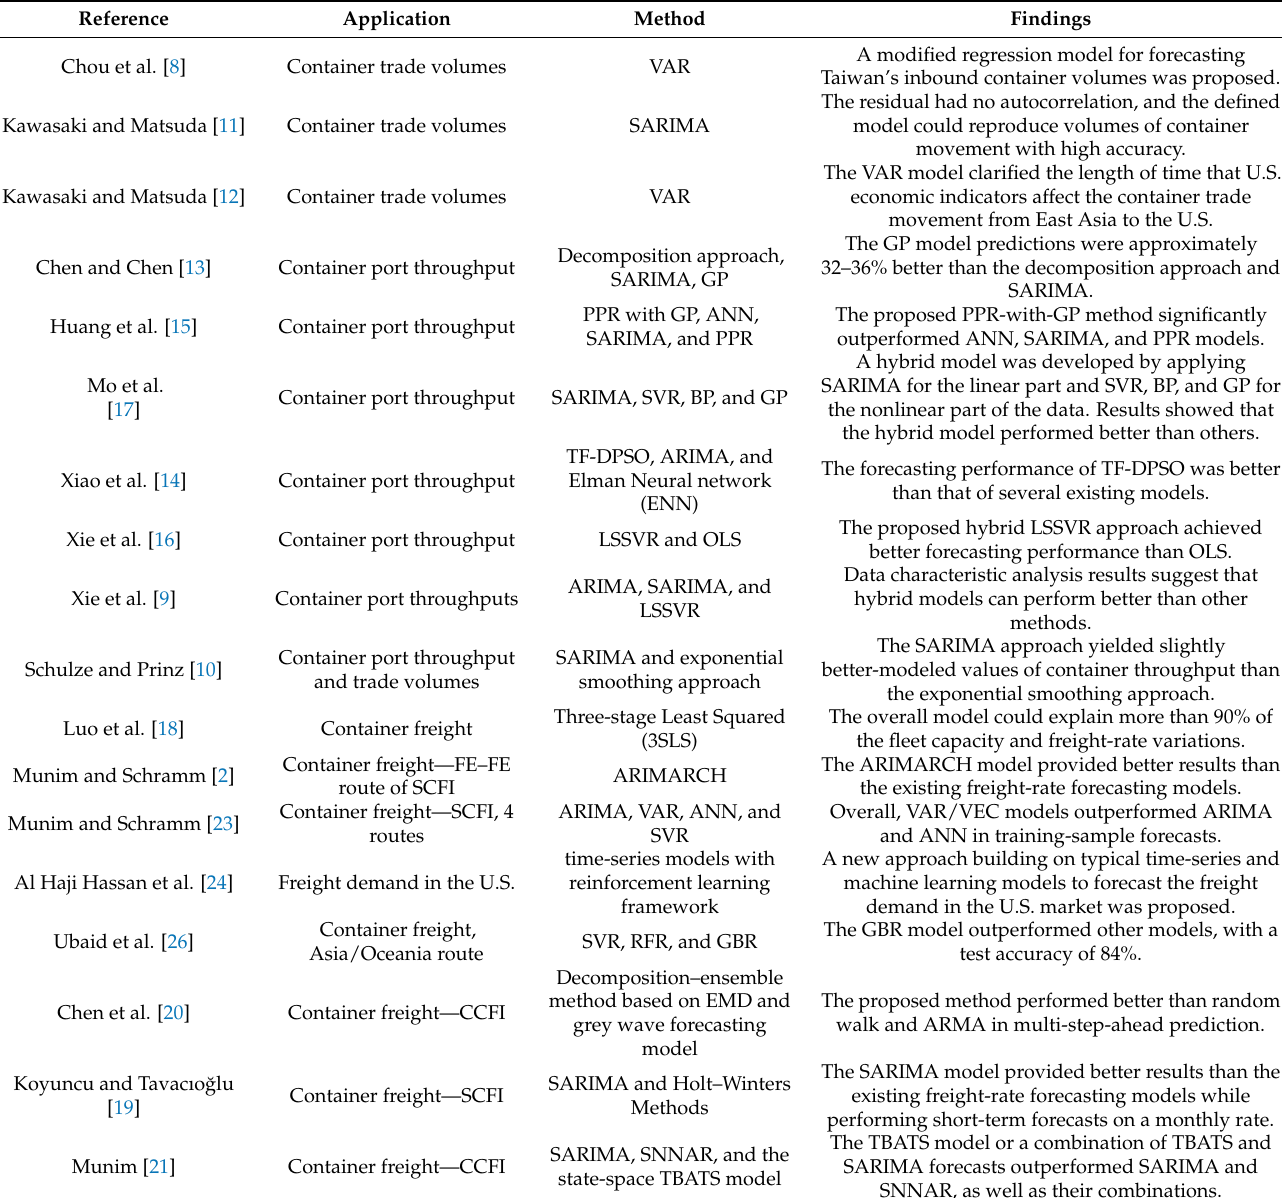
Table 1. Literature review summary of forecasting techniques in the shipping